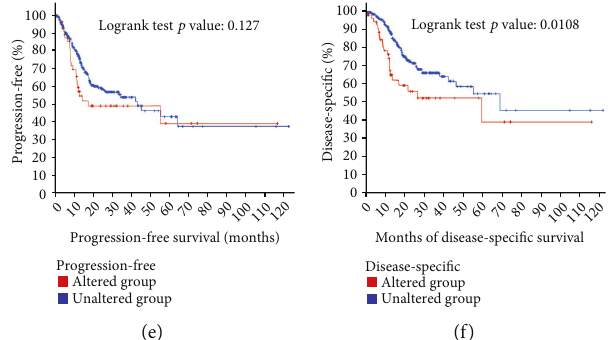
Figure 5: Overall survival (OS), disease-free survival (DFS), progression-free survival (PFS), and disease-speci fi c survival (DSS) of individuals with STAD, as a ff ected by PTTG gene mutations (cBioPortal). (a) Here is a rundown of the many forms of cancer associated with PTTG mutations. Gene changes in PTTGs were found in 24.64 percent of 69 instances with tubular STAD. Mutations in green, gene ampli fi cations in red, profound deletions in blue, elevated levels of mRNA in pink, and numerous changes in grey. (b) Research into PTTG gene mutations in GC. Out of 412 STAD patients studied, 16 percent had inherited mutations in their STAT3 gene. Mutation rates for PTTG1, PTTG2, and PTTG3p were 6%, 5%, and 9%, respectively. Punctuation mutations are grey while missense mutations are green. Gene duplications are shown in green and large deletions in blue. (c – f) Survival, progression, and death rates were analyzed using Kaplan-Meier plots separated by the presence or absence of mutations in the PTTG gene.